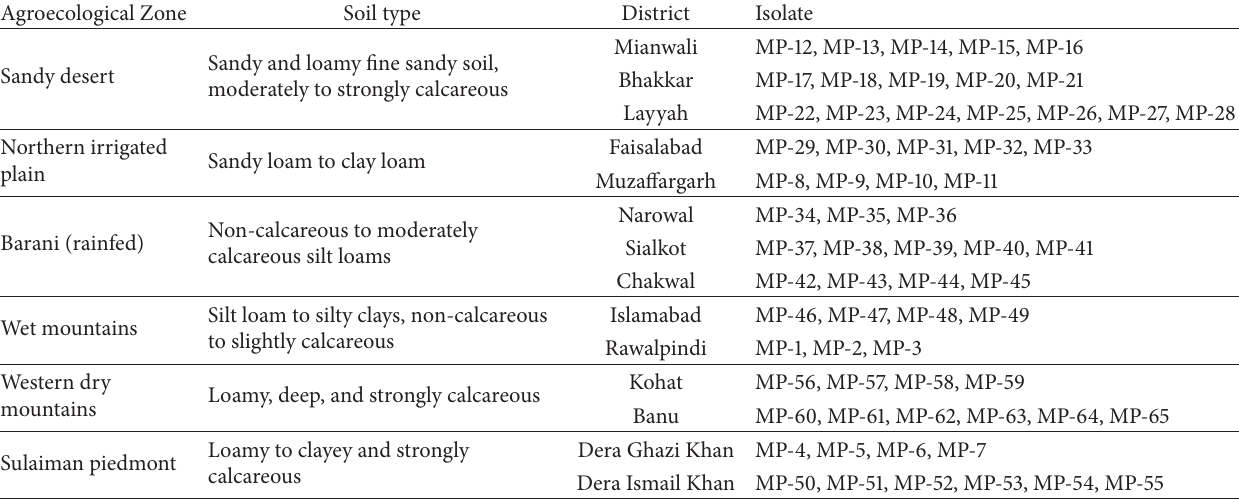
Table 1: Isolates of Macrophomina phaseolina collected from mungbean plants from different agroecological zones. Agroecological